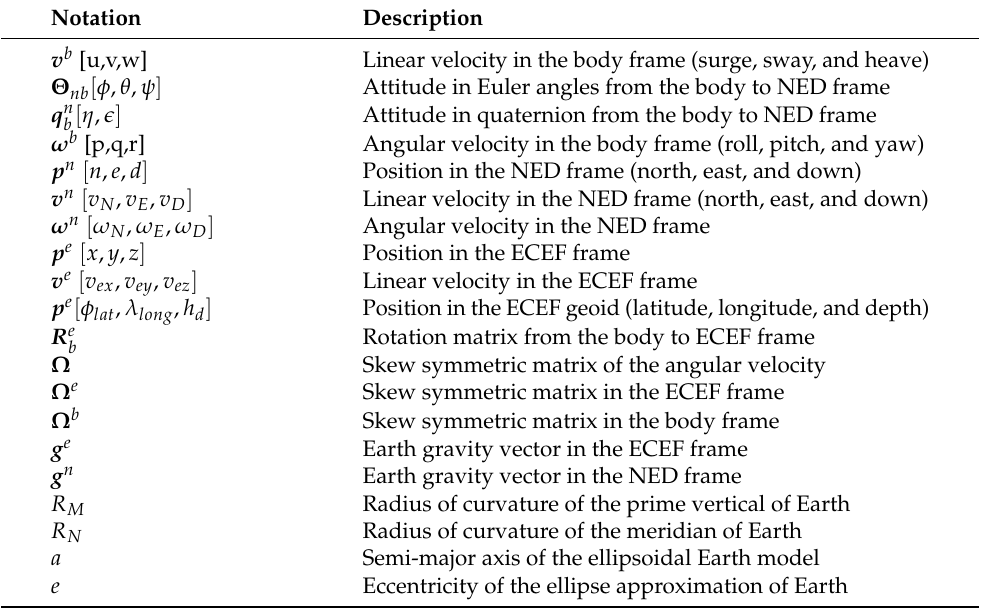
Table 1. Mathematical notations for underwater vehicle